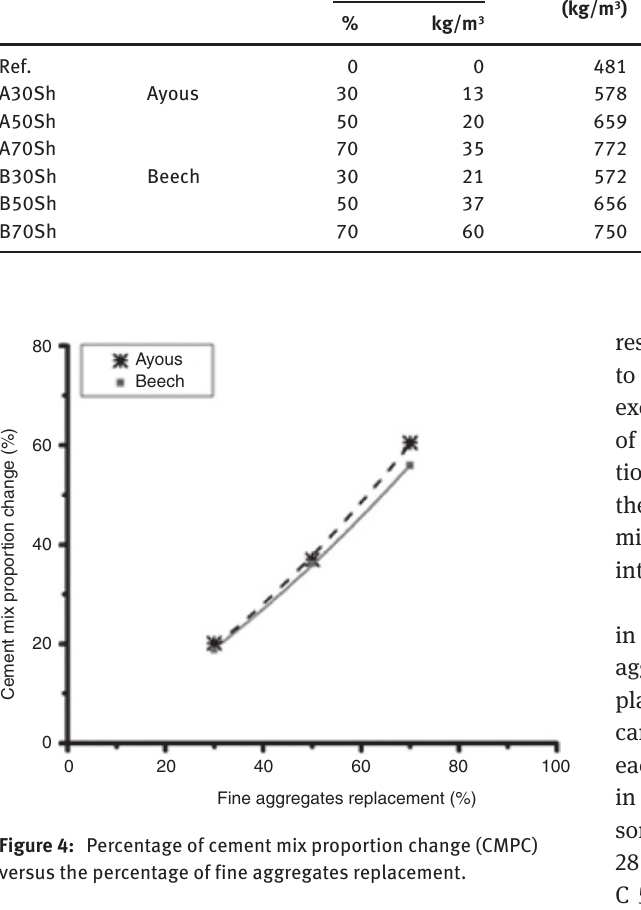
Table 1: Mix proportions. Samples